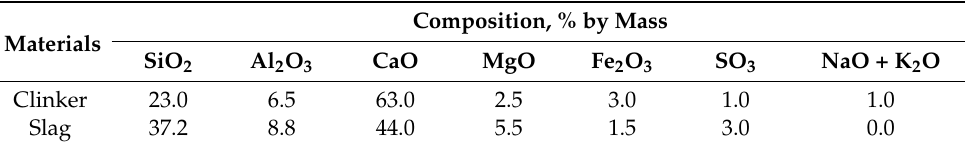
Table 1. The chemical composition of raw materials.